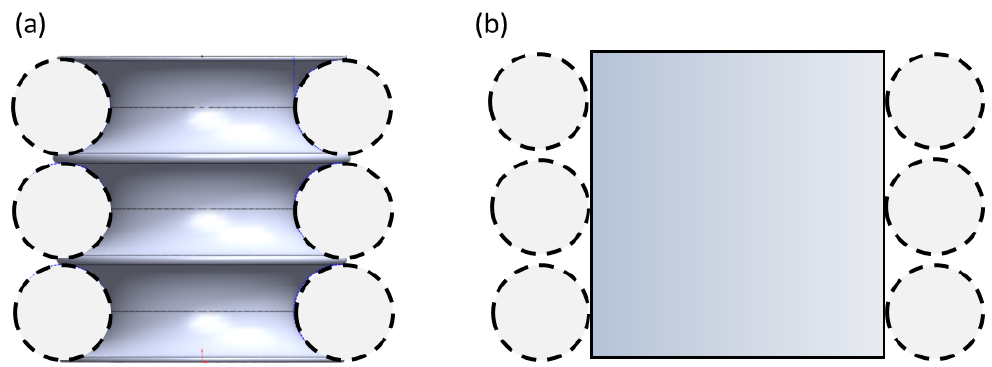
Figure 1. Conceptual views of ( a ) original Optiwind 150 kW wind turbine design. ( b ) Conceptual smooth cylinder design. Rotors shown schematically by dotted circles. In application, direction of wind would be into the page so that turbine blades are at ±90° with respect to the wind direction.